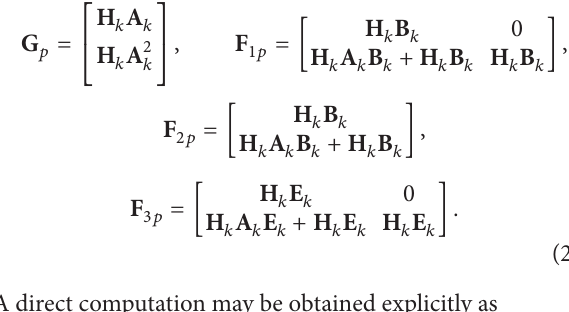
Figure 7: Working phases three and four (fed by 𝑈 𝐶